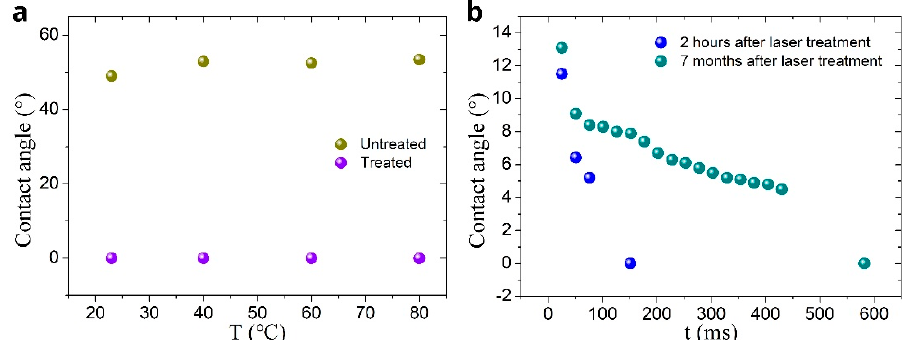
Figure 7. ( a ) Contact angle of a 2 µL water drop on untreated and treated sample surfaces as a function of temperature. ( b ) Contact angle dynamics of a 2 µL water drop on the treated sample measured immediately after laser processing and 7 months later.